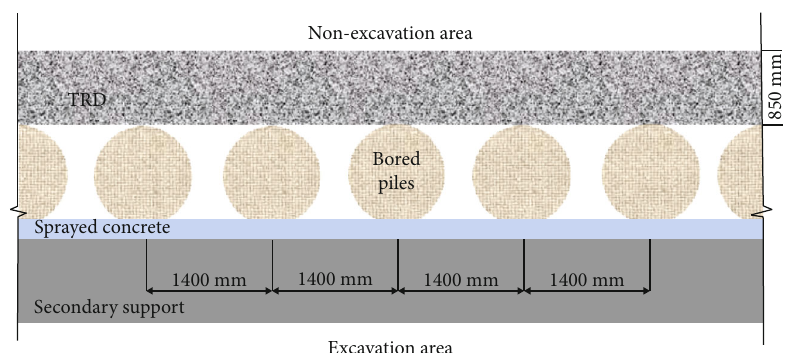
Figure 11: TRD position in the support system.